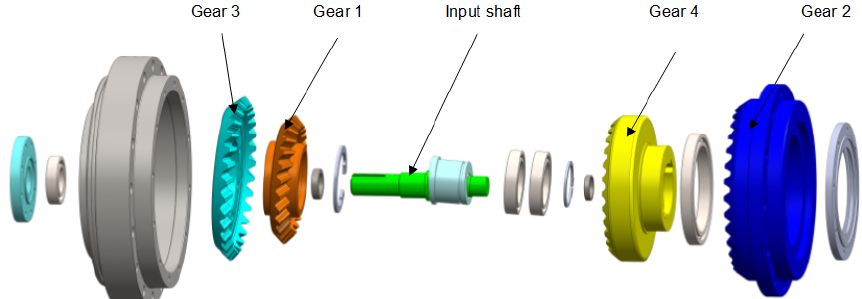
Figure 1. 3D model of the two-stage nutation reducer.